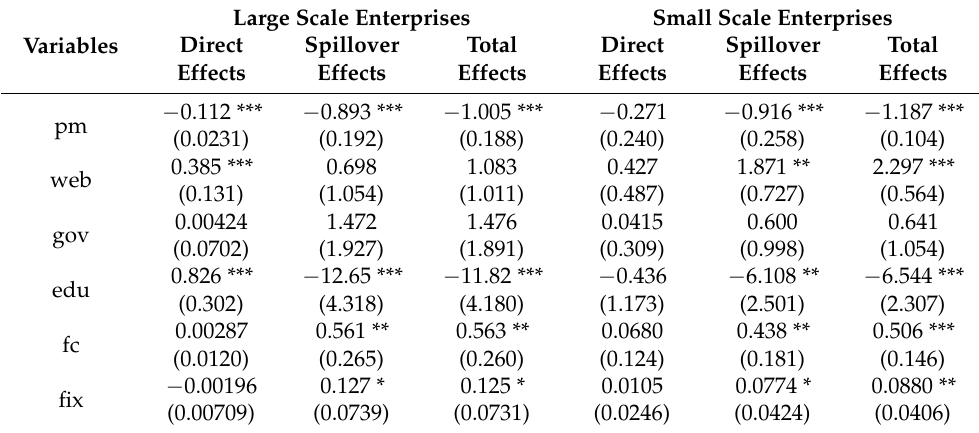
Table 10. Results based on heterogeneity of enterprises’ scale